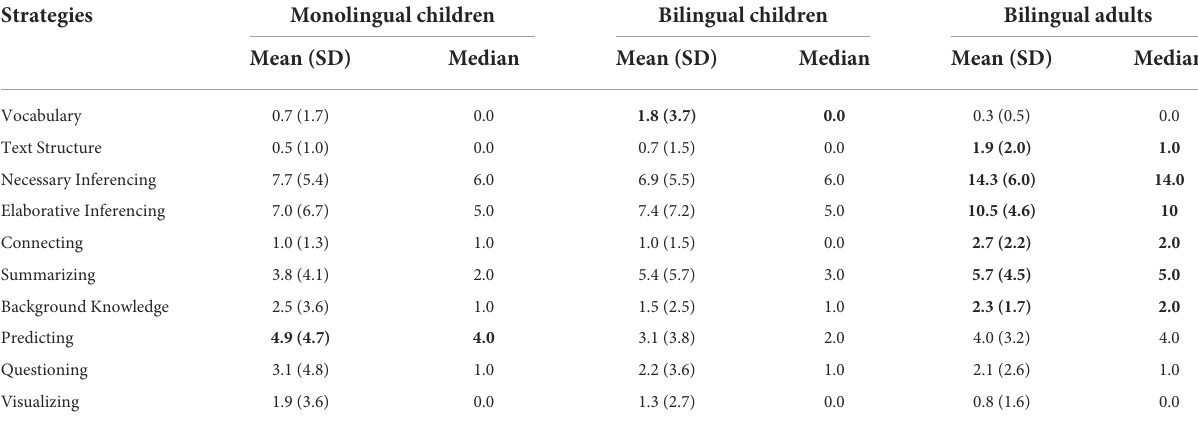
TABLE 2 Mean and median sums of strategy use as a function of language group.